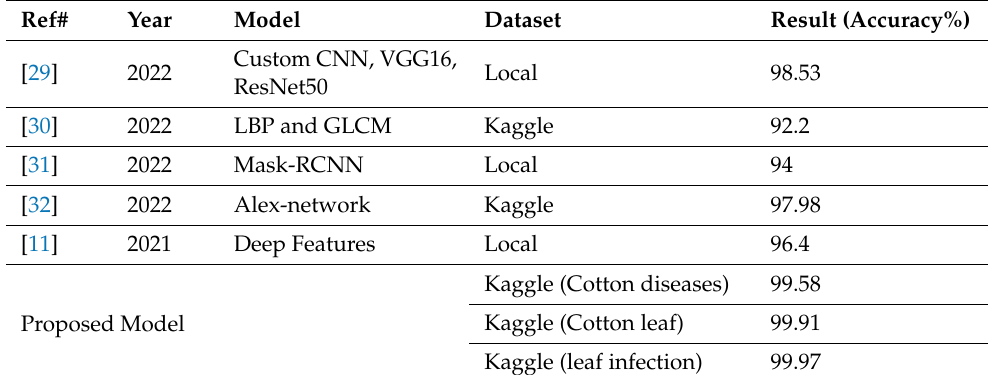
Table 5. Comparison of the proposed cotton disease classification results.